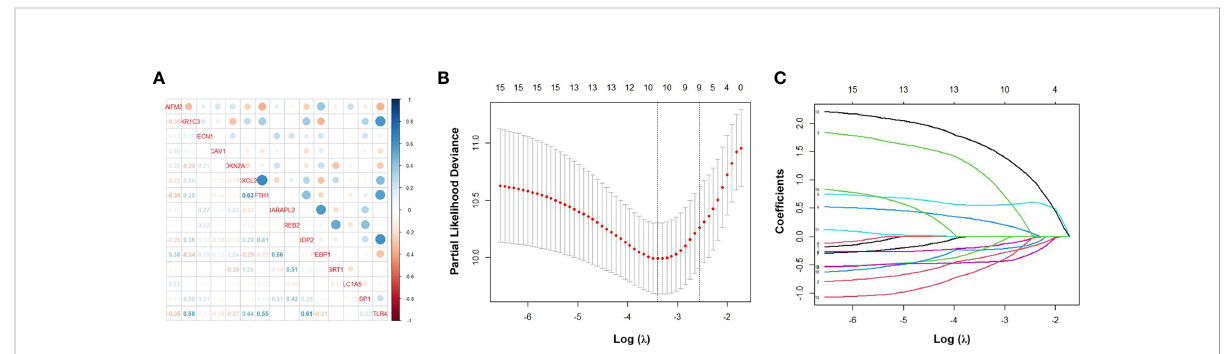
FIGURE 2 Identi fi cation of ferroptosis-related genes signature by LASSO regression algorithm in CLL. (A) Correlation analysis of the 15 FRGs. (B) Nine prognostic FRGs were identi fi ed by LASSO analysis based on optimal weight coef fi cients ( l ). (C) The LASSO coef fi cient pro fi les of the nine-FRG